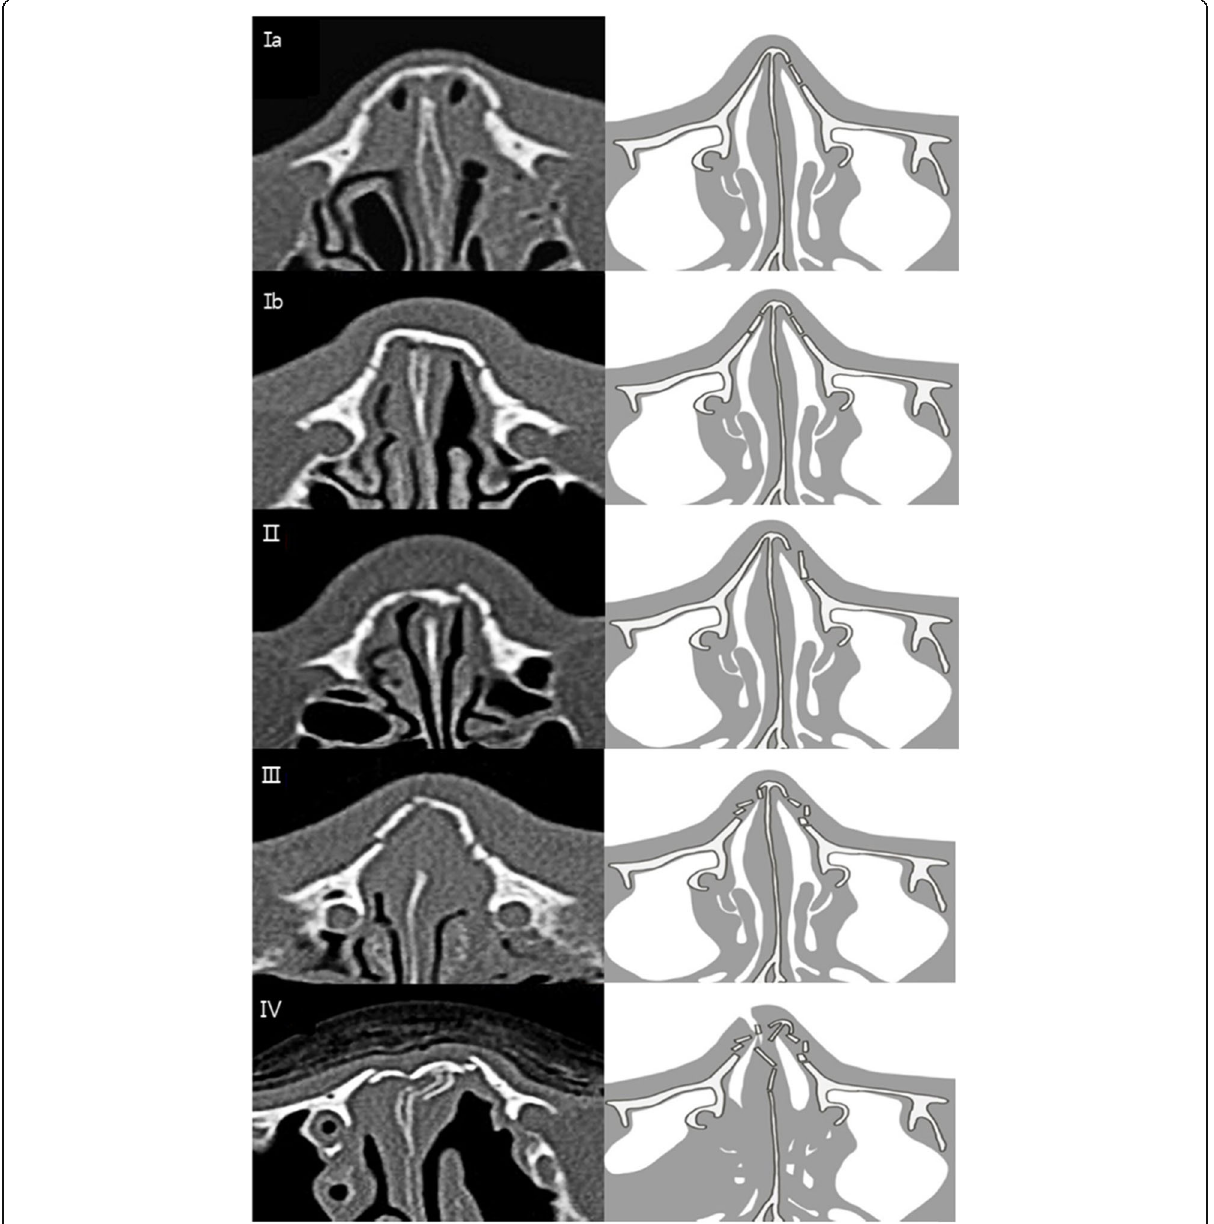
Fig. 1 Classification of nasal bone fracture. Ia Simple unilateral, non-displaced. Ib Simple bilateral, non-displaced. II Simple displaced. III Closed comminuted. IV , Open comminuted or